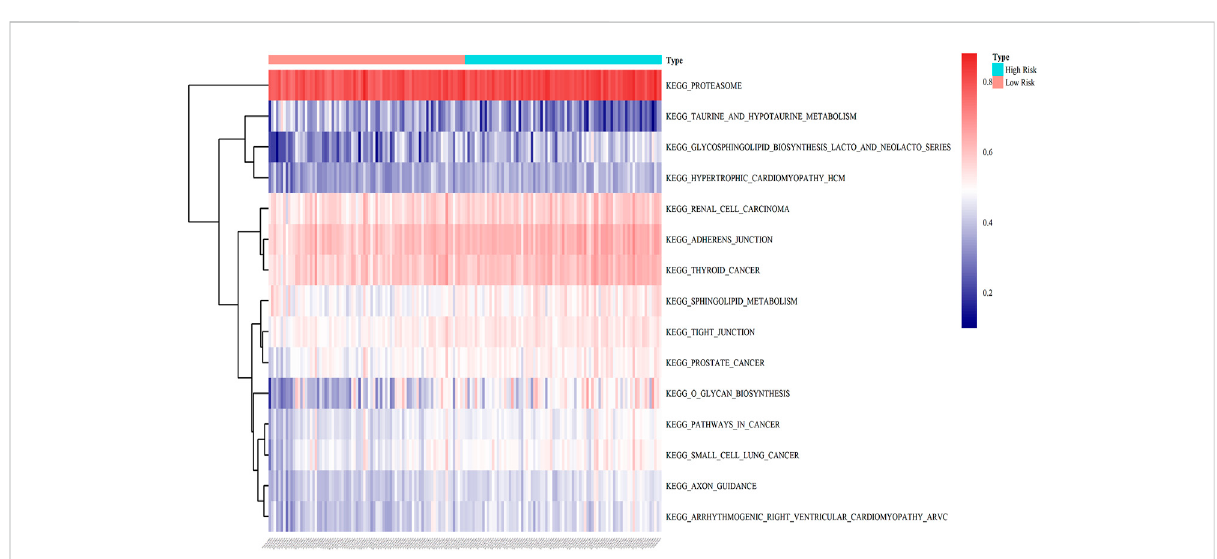
FIGURE 9 GSVA enrichment analysis of biological behaviors between the low- and high-risk groups in the training dataset. The heatmap was applied to visualize the top 15 distinct KEGG pathways arranged from small to large according to the p value; red indicates activated pathways, and blue indicates inhibited